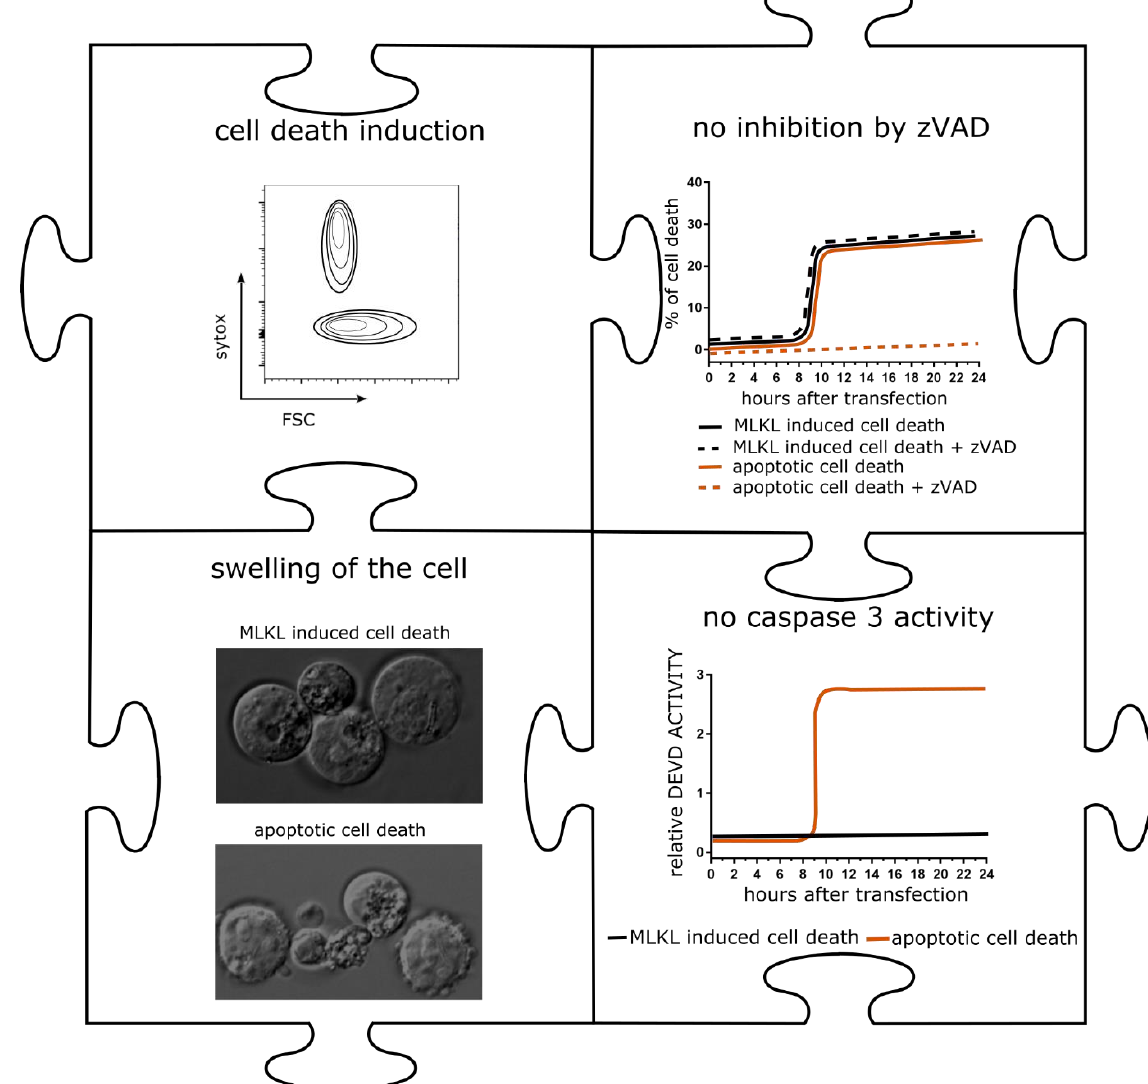
FIGURE 2: Hallmarks of mRNA encoding MLKL induced cell death. Schematic representation of in vitro cell death of B16 cells transfected with MLKL-mRNA. Upper left : 24 hours after transfection, cells were collected and analyzed by flow cytometry. The graph shows a sche- matic flow cytometric plot of sytox positive cells. Upper right: Impact of the pan-caspase inhibitor zVAD-fmk on cell death induction of apoptotically dying cells or cells transfected with MLKL-mRNA. Lower right: Caspase 3 activity over time in apoptotically dying cells or cells transfected with MLKL-mRNA. Lower left : Still images of apoptotically dying cells or 24 h after transfection with MLKL-mRNA visualized by time-lapse